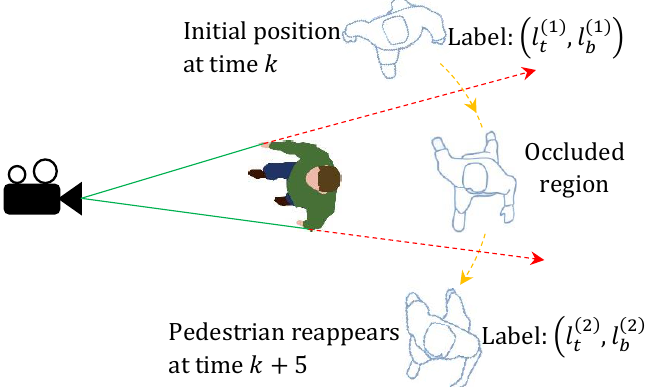
( 1 ) ( 1 ) ) is tracked until time k . The pedestrian is then occluded , (cid:96) t b ( 2 ) ( 2 ) ) from time k + 5 , (cid:96) t b